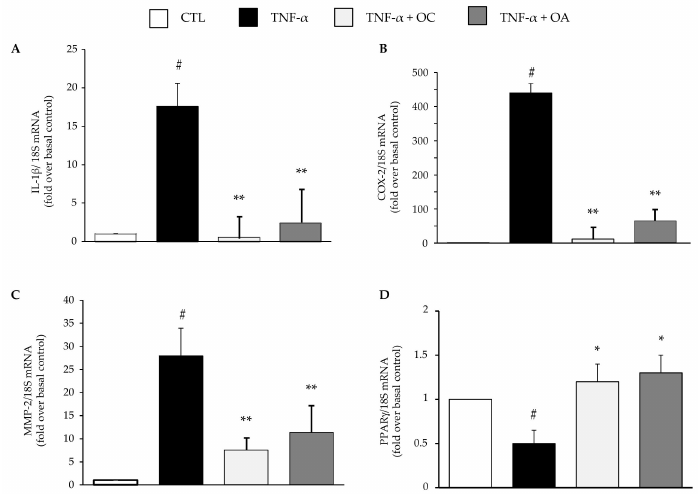
Figure 4. Modulation by OC and OA of mRNA expression levels of cytokines, inflammatory and remodeling enzymes, and metabolic transcriptional regulator associated with adipocyte inflammation. SGBS adipocytes were pretreated with OC or OA 25 µ mol / L (6 h) and then treated with 10 ng / mL TNF- α for 18 h. Total RNA was extracted from cells, and mRNA levels of interleukin-1 β (IL-1 β ) ( A ), cyclooxygenase-2 (COX-2) ( B ), metalloproteinase-2 (MMP-2) ( C ), and peroxisome proliferator-activated receptor- γ (PPAR γ ) ( D ) were measured by qPCR using specific primers and probes and normalized to 18S RNA. Data (means ± SD, n = 3) are expressed as fold induction over unstimulated control (CTL). # p < 0.05 versus CTL. * p < 0.05 versus TNF- α alone. ** p < 0.01 versus TNF- α